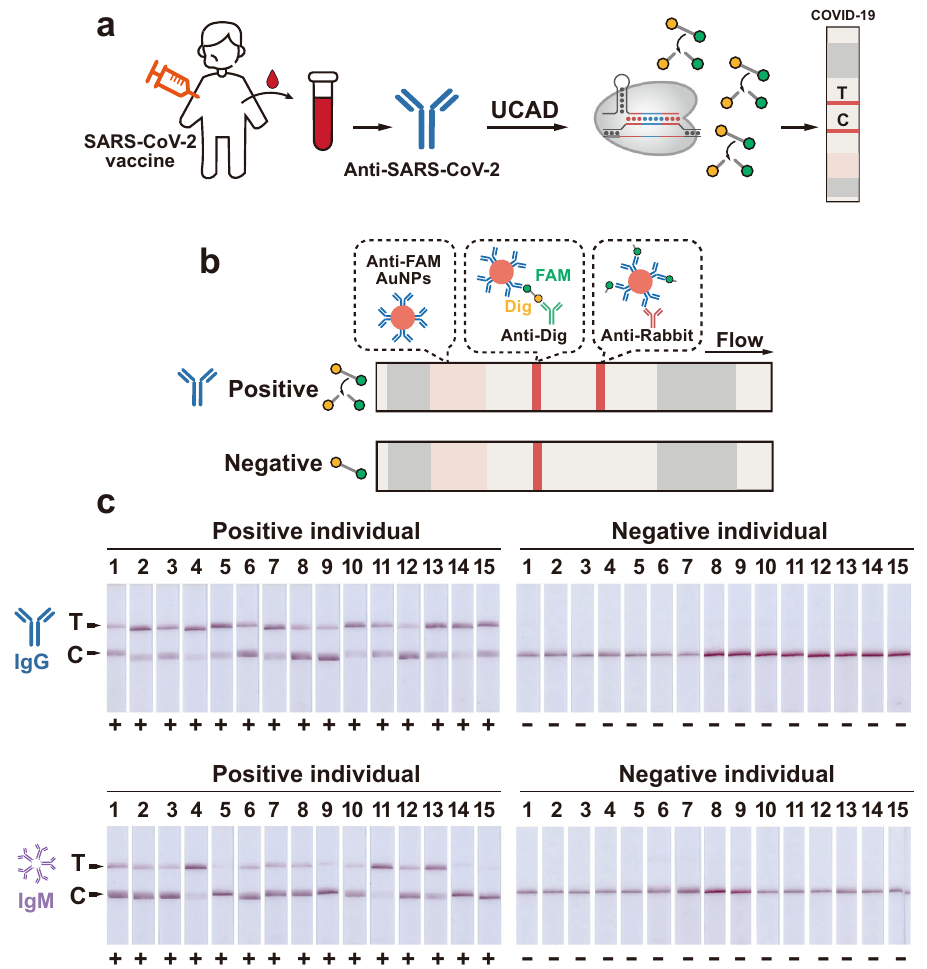
Fig. 5 | Integrating UCAD with lateral fl ow readout. a Schematic illustration of lateral fl ow readout for UCAD for the detection of anti-SARS-CoV-2 IgG and IgM. b The design of the lateral fl ow strip that captured all anti-FAM labeled AuNPs at C-lineinthe absence ofthetargetantibody. Inthe presenceof ant-SARS-CoV-2IgG